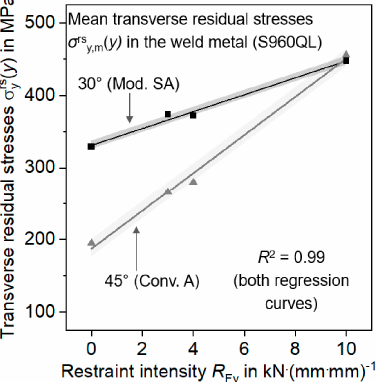
Figure 1. Mean transverse residual stresses in the weld metal as a function of restraint intensity R Fy for different component-like tests and for two different weld seam configurations [25].